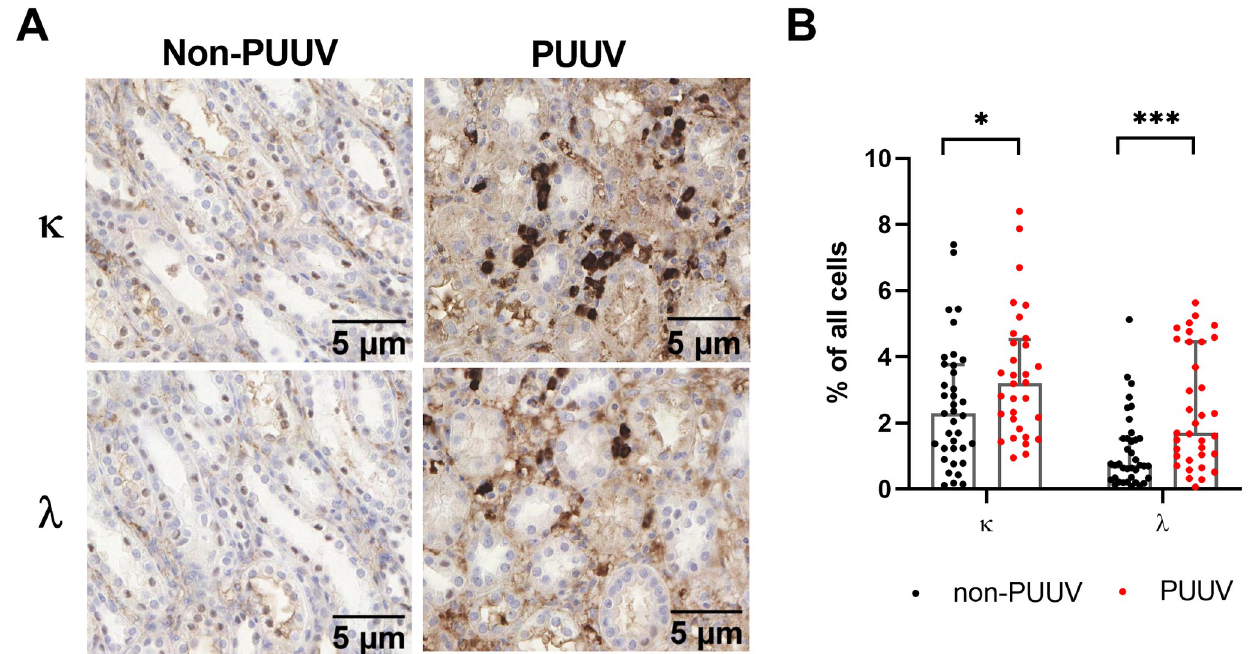
Fig 4. Plasma cells infiltrate kidneys during acute PUUV-HFRS. Sections from archival kidney biopsies of acute PUUV-HFRS or from patients with a kidney disease of another etiology were stained for κ or λ light chains by immunohistochemistry. ( A ) Representative images of κ and λ light chain staining of a patient with acute PUUV-HFRS and one patient with another cause of kidney dysfunction (glomerulonephritis) as control, showing the presence of infiltrating plasma cells in kidneys during acute PUUV-HFRS. ( B ) Quantification of the number of plasma cells in non-PUUV and acute PUUV-HFRS (n = 37–38 for non-PUUV controls and 32–35 for PUUV-HFRS). The medians across groups were compared by Mann-Whitney test and significant differences reported as � = p < 0.05 and ��� = p < 0.001. The bars indicate medians + interquartile